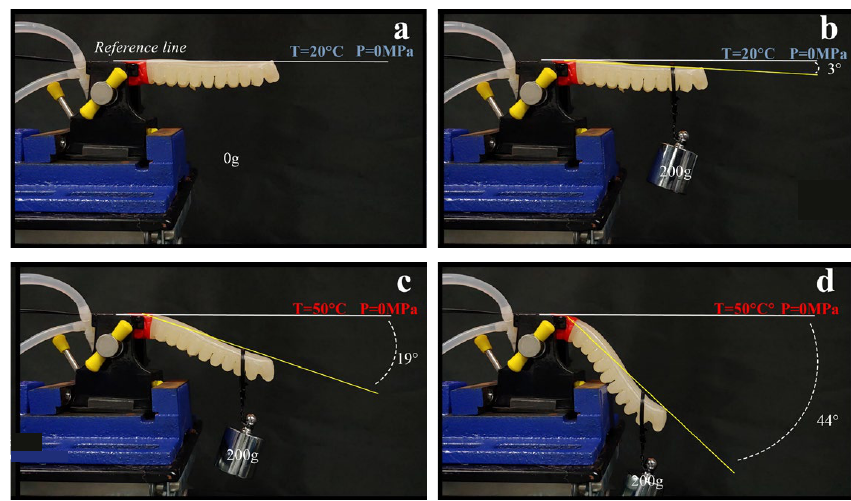
Figure 3. Demonstration of stiffness variation in the actuator at different conditions. ( a ) Initial state (T = 20 ◦ C, P = 0 MPa) of the actuator with no load. The white line denotes reference. ( b ) Bending of the actuator when a load of 200 g is suspended to the actuator at 20 ◦ C and 0 MPa. The yellow line represents the bending profile of the actuator. ( c ) Bending of the actuator when temperature increased to 50 ◦ C while maintaining its pressure (0 MPa) and load (200 g). ( d ) Bending of the actuator during prolonged loading (200 g) at 50 ◦ C and 0 MPa. The stiffness variation of the actuator at different temperature and pressure is shown in the Movie S2.